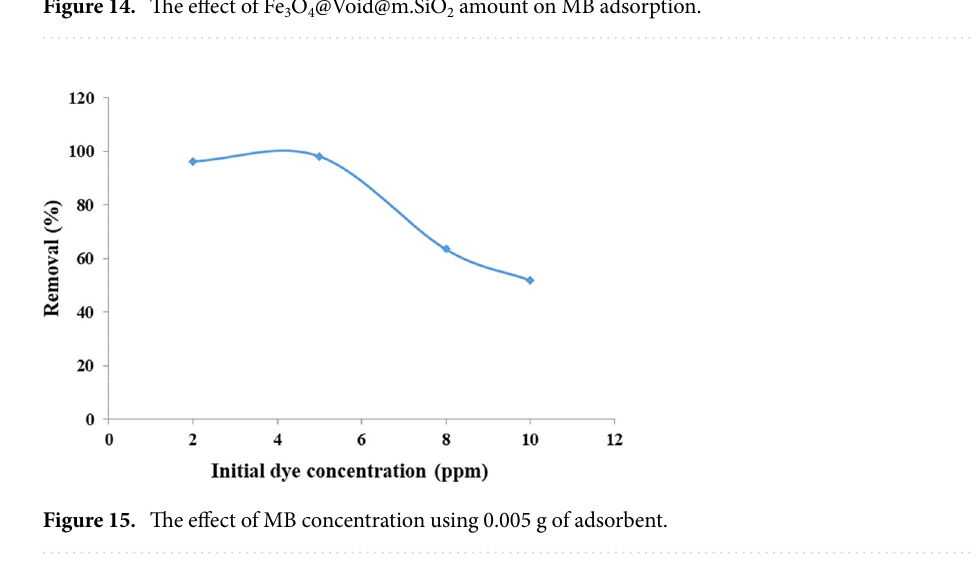
Figure 14. The effect of Fe 3 O 4 @Void@m.SiO 2 amount on MB adsorption.